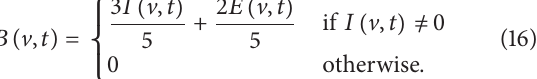
Figure 10: The base score curves from 2002 to 2012 for two vulnerability types and the mean of 𝐵( V ,𝑡) . This indicates the base score of a vulnerability changes when V (𝑡) increases over time, where 𝑇 = {2002, 2003, .. .}